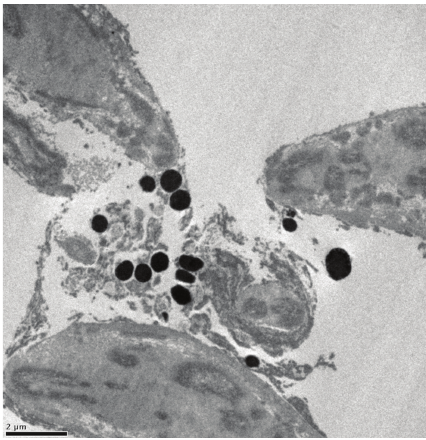
Figure 3: TEM of ALT-treated tissue (300 mW) showing disruption of trabecular cells with extracellular pigment granules.